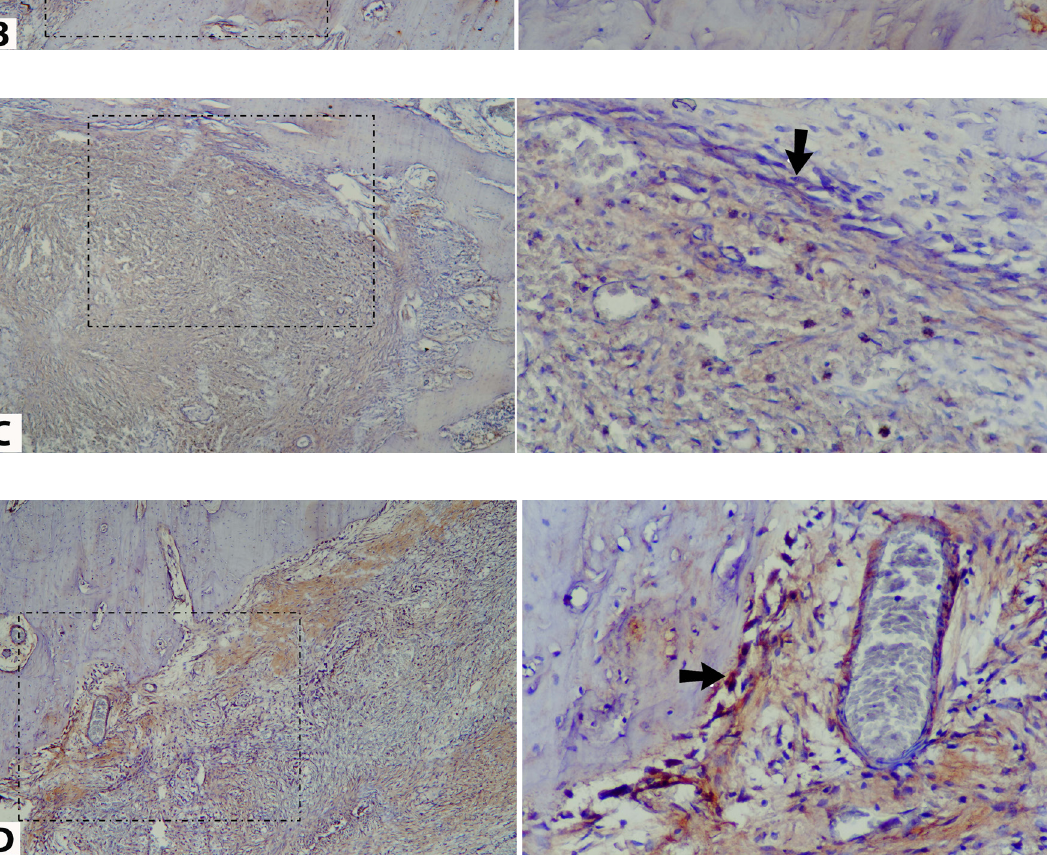
FIGURE 4 - ALP expression on day 14. A. Control / PEG Group, B. Propolis extract + PEG group, C. BBG + PEG group, D. Propolis extract + BBG + PEG group. Each figures consist of 100x and 400x magnification. The arrows showed cell with positive expression of